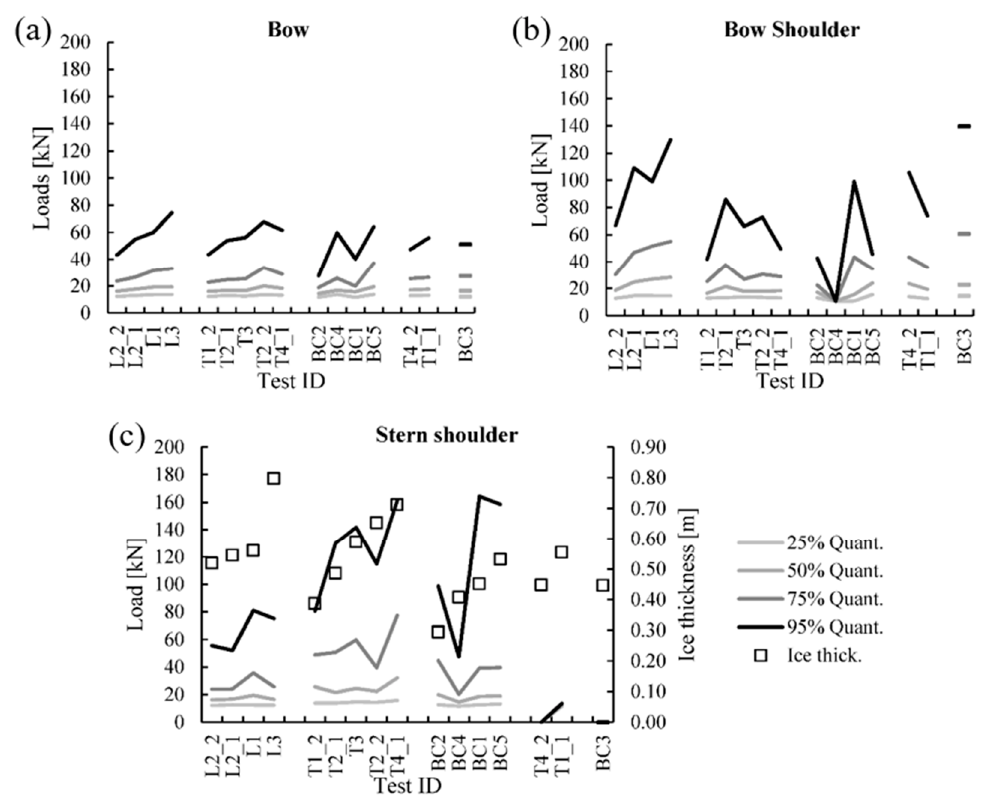
Figure 11. The 25%, 50%, 75%, and 95% quantiles of measured ice-induced load magnitudes at ( a ) bow, ( b ) bow shoulder, and ( c ) stern shoulder, with measured maximum ice thickness with the stereo camera system.